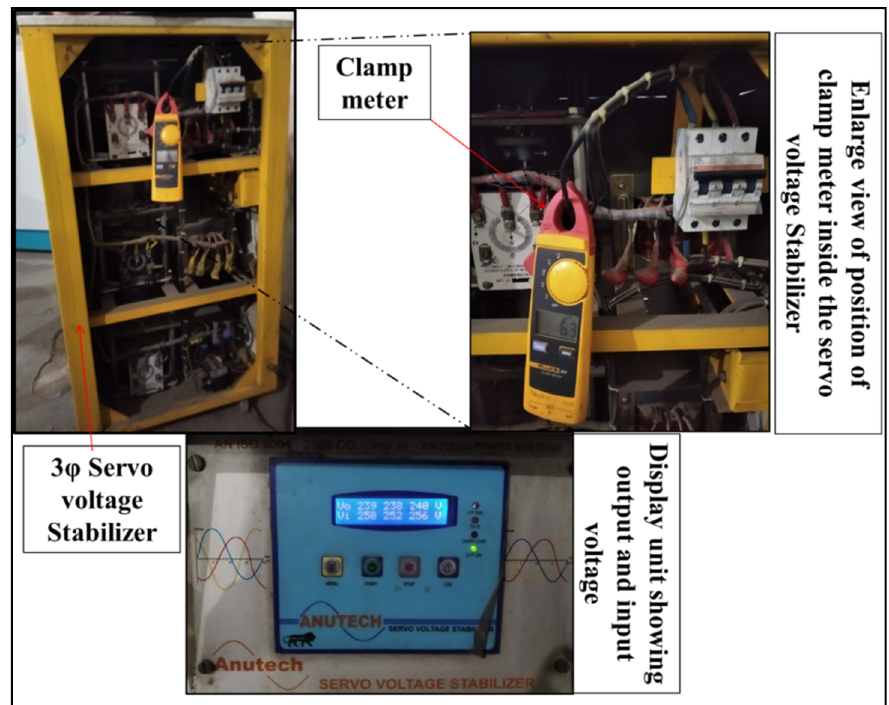
Figure 7. Measurement of energy consumption by clamp meter during manufacturing of miniature- sized ratchet wheels by